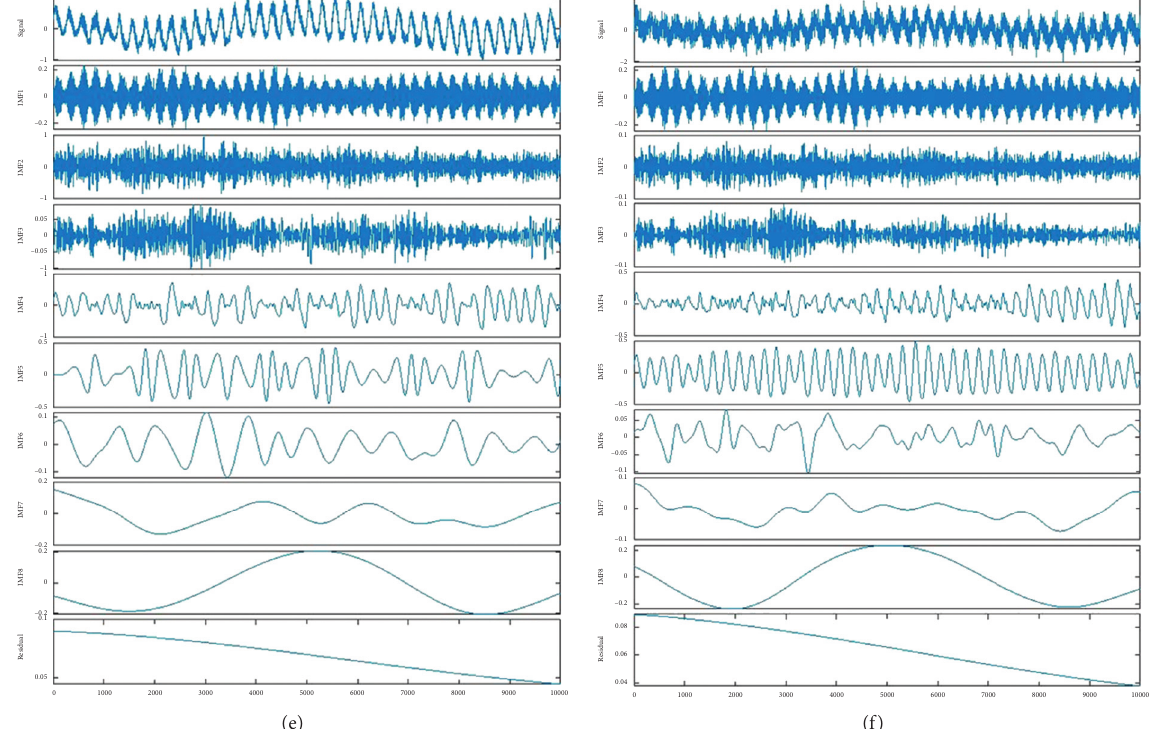
Figure 11: IMFs of VPV data processing by different methods. (a) IMFs obtained by EMD. (b) IMFs obtained by EEMD with WGN in 0dBW. (c) IMFs obtained by EEMD with WGN in − 10dBW. (d) IMFs obtained by EEMD with WGN in − 30dBW. (e) IMFs obtained by EEMD with WGN in − 50dBW. (f) IMFs obtained by NSEEMD proposed in this